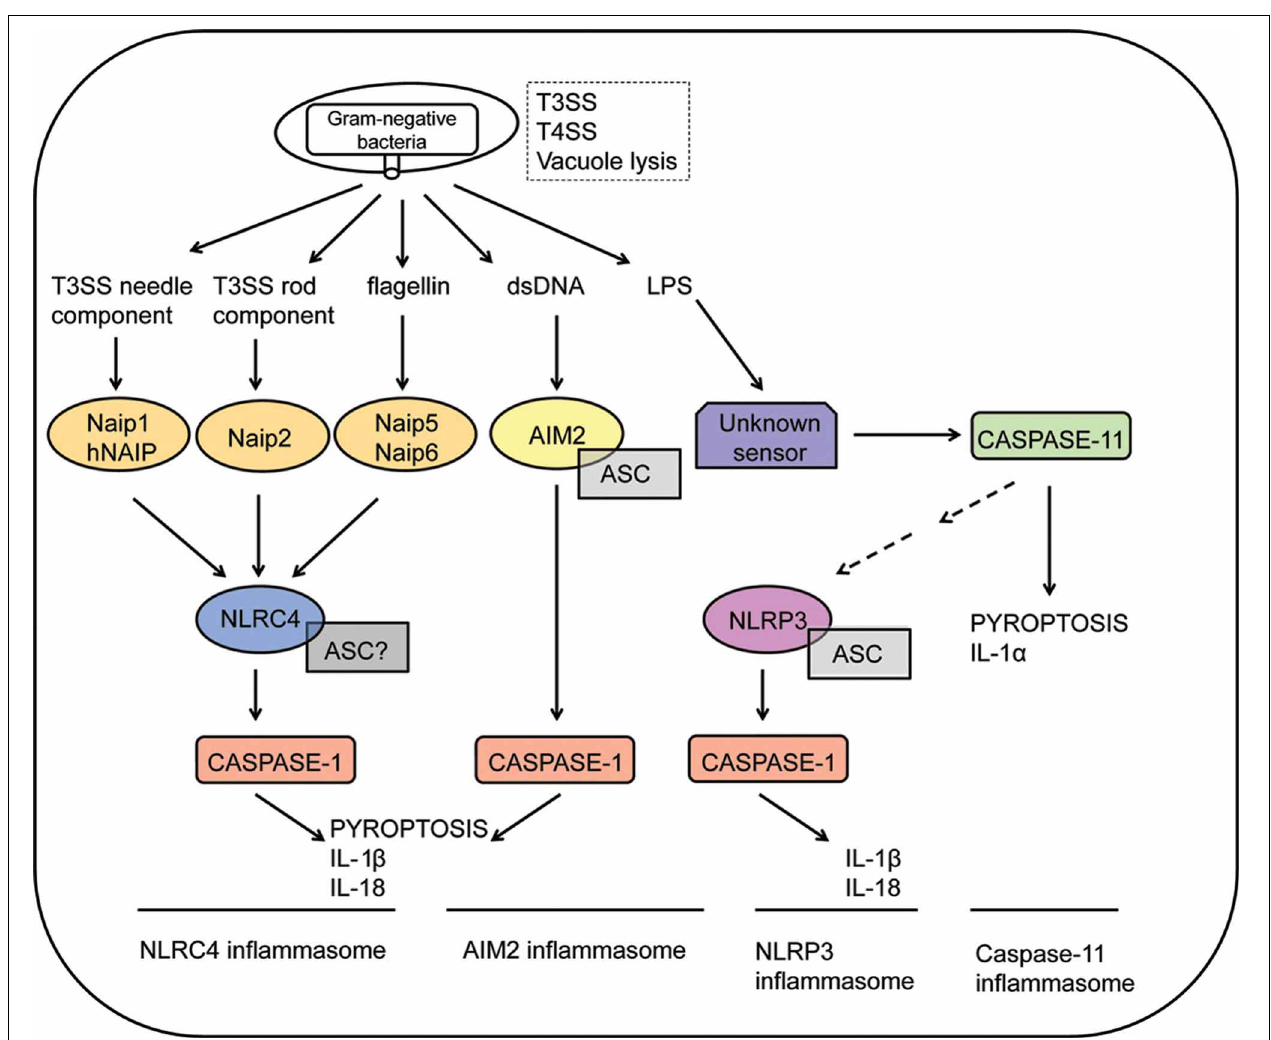
FIGURE 1 | Inflammasome activation in response to Gram-negative bacteria. Intracellular sensing of Gram-negative bacteria that violate cytosolic compartments by expressing type III or type IV secretion systems (T3SS and T4SS, respectively) or by inducing vacuolar lysis. NLRC4 inflammasomes are activated in response to recognition of bacterial flagellin by Naip5, T3SS needle proteins by murine Naip1 or by human NAIP (hNAIP), or T3SS rod proteins by Naip2. Activation of the NLRC4 inflammasomes culminates in caspase-1 activation, leading to IL-1 β /IL-18 secretion and pyroptosis. The requirement of ASC to the assembly of the NLRC4 inflammasomes is